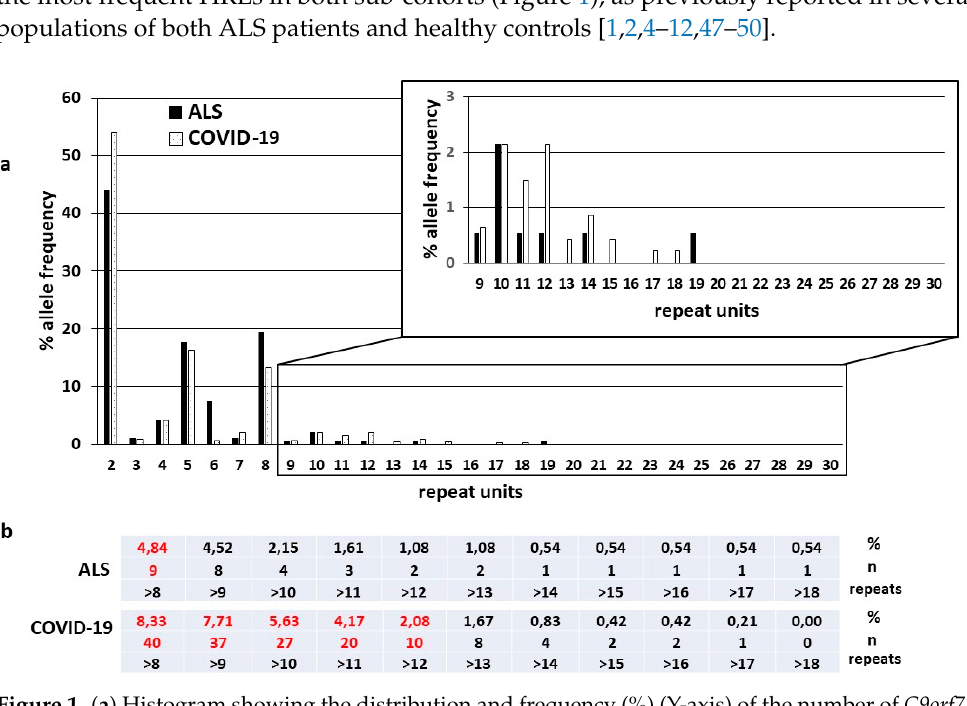
Table 1. Demographic data and C9orf72 hexanucleotide expansions in the cohort of 240 corona-